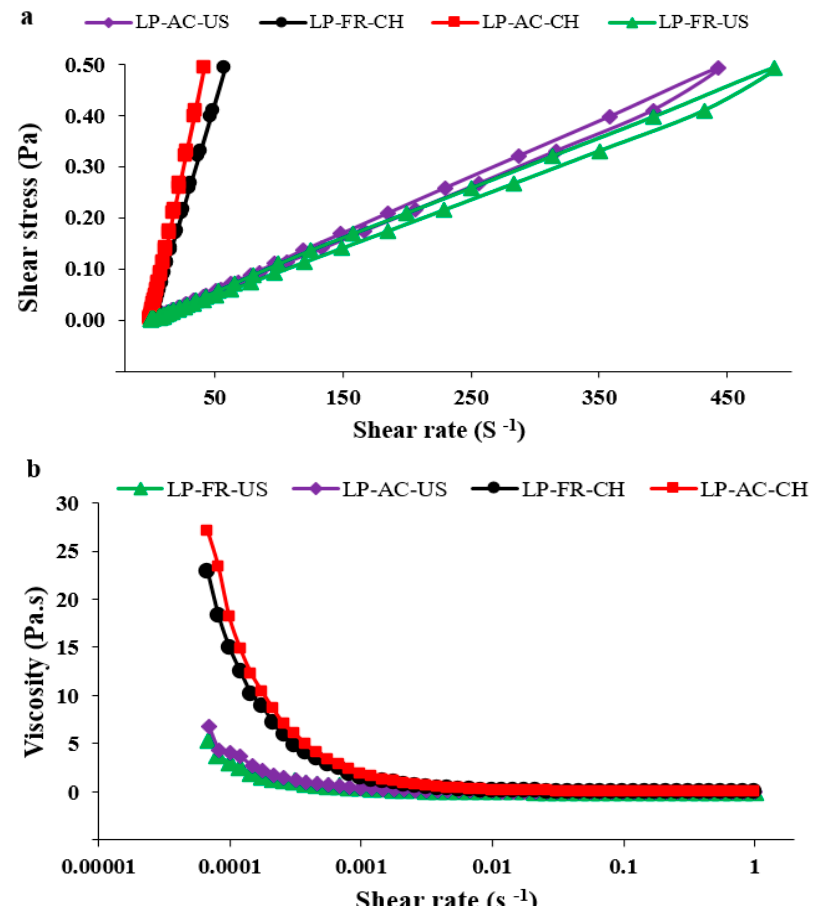
Figure 3. ( a ) Time dependency of the flow behavior of nanoliposomes with various formulation; ( b ) Shear viscosity at low shear rate.